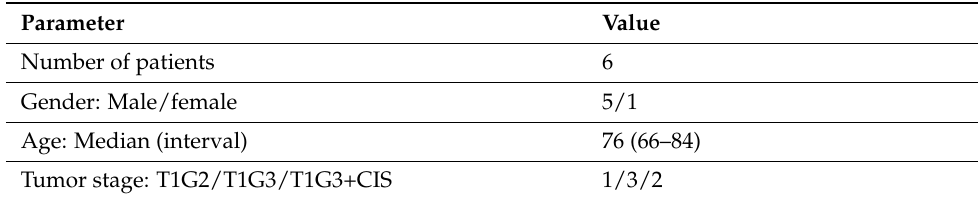
Table 1. Clinical patient